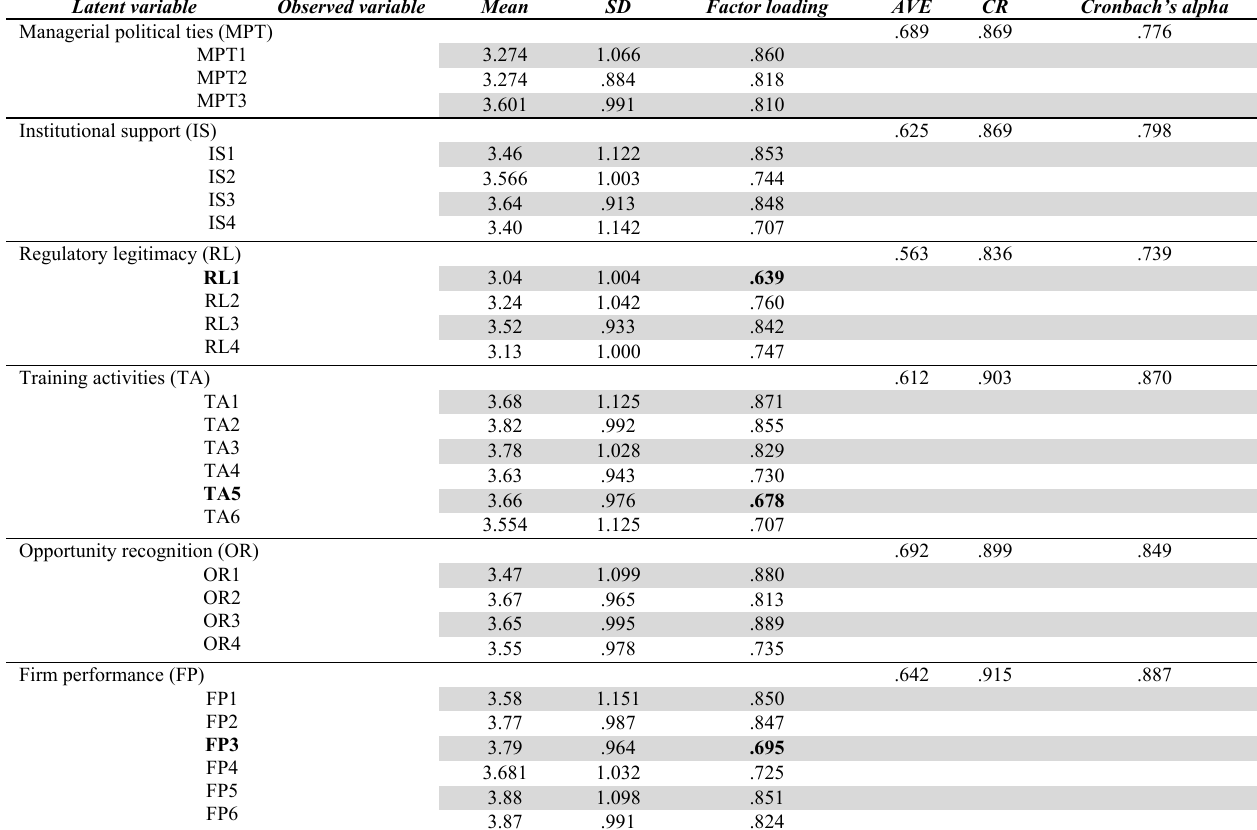
Construct reliability and convergent validity analysis